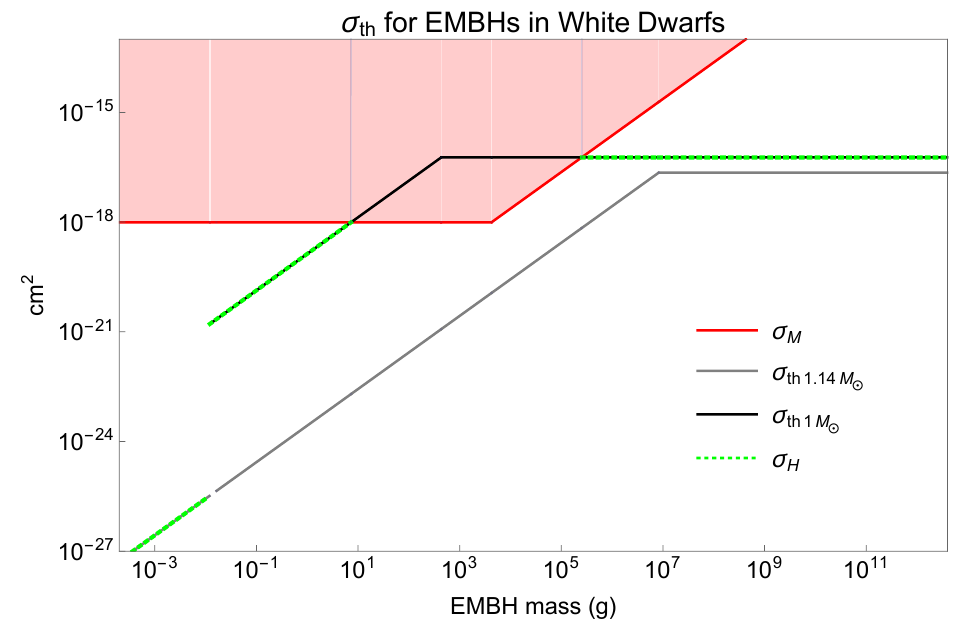
Figure 5 . The black and gray lines above show the minimum catalysis cross sections, σ th , needed to start convection at all cooling times considered in 1 M (cid:12) WDs and WD J0551+4135, respectively. The red region excludes implausible cross sections in the WDs, with the red line marking σ M . No physically viable value for σ th for 1 M (cid:12) WDs exists for EMBH masses where the black line crosses into the red region. Here, some form of the original annihilation bound stands. Heating bounds are set wherever the annihilation bounds break down ( M < 8 g and 2 × 10 5 g < M ) using σ H , which is marked by the green dotted line and follows whichever value of σ th for the two sets of WDs is